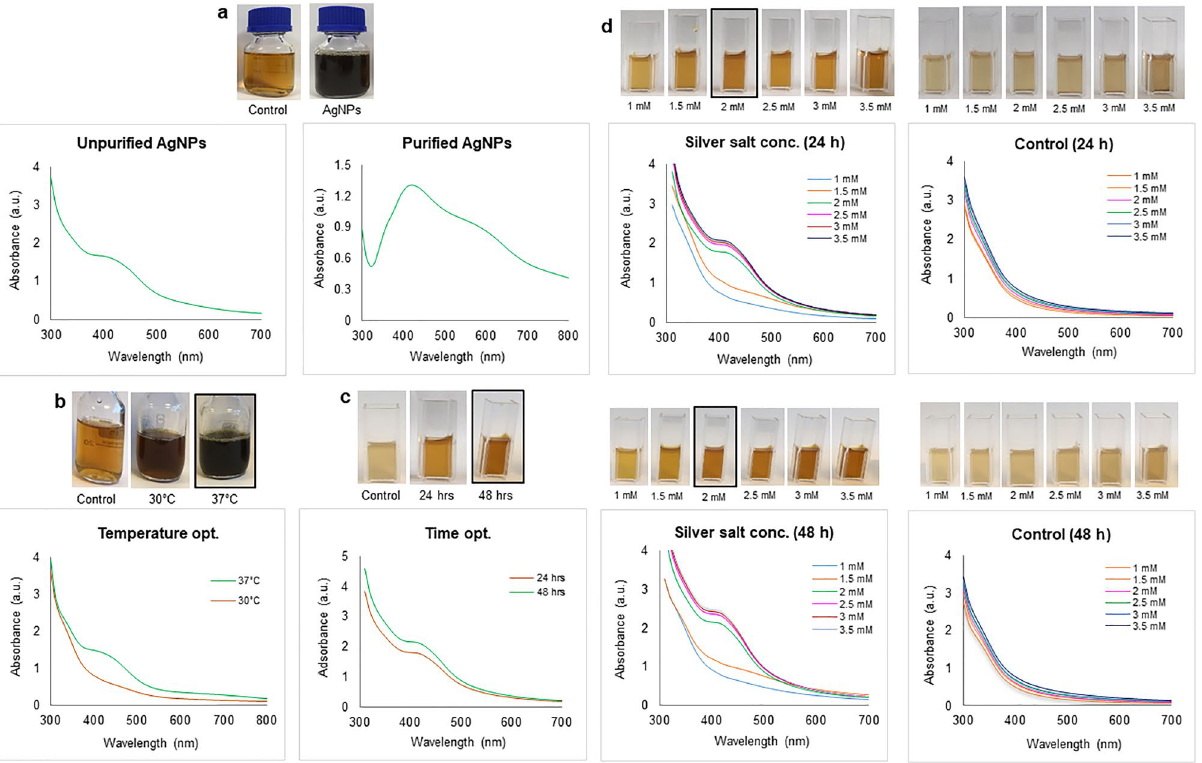
Figure 3. UV/Vis spectra ( a ) unpurified AgNPs in supernatant and purified AgNPs. Optimization studies based on UV/Vis spectral analysis ( b ) temperature, ( c ) time, and ( d ) silver salt